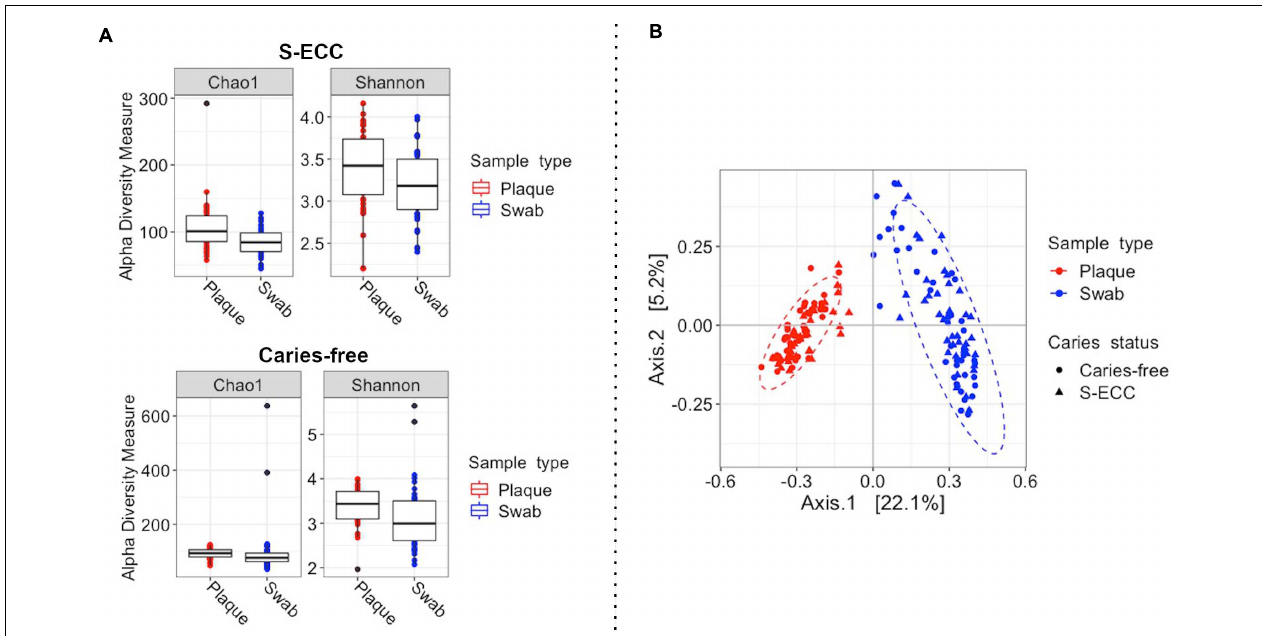
FIGURE 2 | Bacterial diversity of dental plaque and oral swab samples from children with S-ECC and those caries-free. (A) For alpha diversity (within-sample) the Shannon and Chao1 diversity and richness measures were calculated according to sample type in both caries-free and S-ECC groups. A significant difference between oral swab and dental plaque alpha diversity and richness was observed in both caries-free and S-ECC groups ( P < 0.05, paired Wilcoxon test). (B) For beta (between-sample) diversity, Bray-Curtis distances were calculated, followed by principal coordinates analysis (PCoA). The plot shows the separation of samples according to sample type (pseudo-F = 40.4, R 2 = 0.2, P = 0.001, PERMANOVA accounting for the children’s caries-status). The ellipses represent a 95% confidence level. S-ECC, severe early childhood